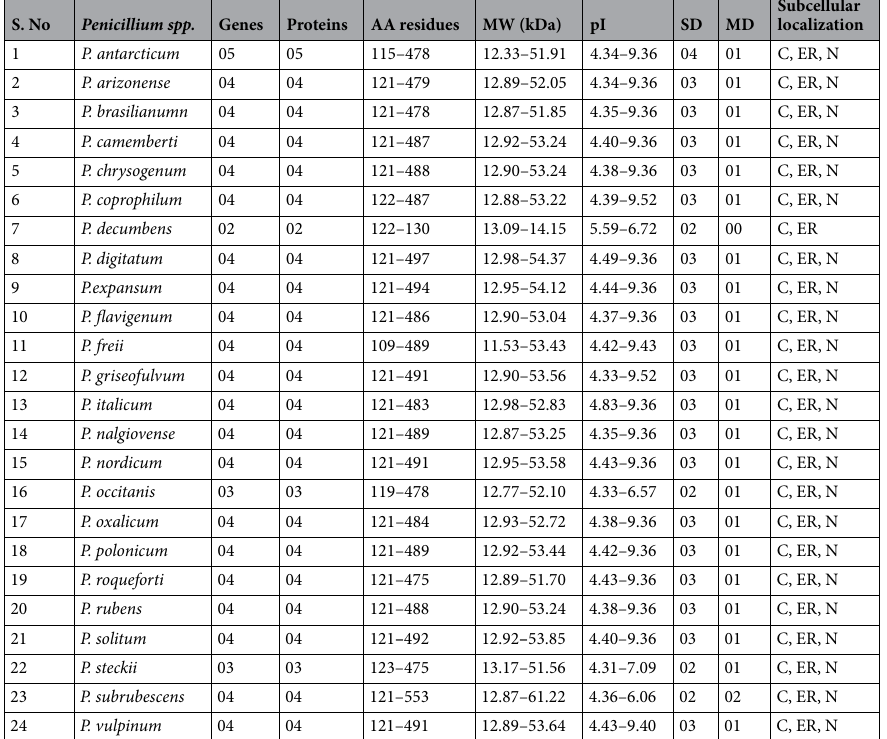
Table 5. Genome-wide analysis of FK506-binding proteins (FKBPs) in different Penicillium spp. AA: amino acids; C: cytoplasm; ER: endoplasmic reticulum; kDa: kilodalton; MD: multi-domain; MW: molecular weight; N: nucleus; pI: isoelectric point; SD: single